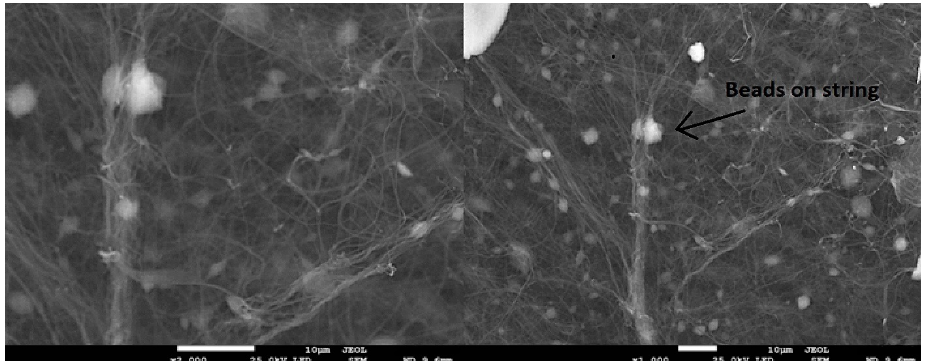
Figure 5. An example of beads on strings of textile resulting from polymerized electro-spun V 2 O 5 with PVP + Graphene Oxide diluted in water. Reprinted from ref. [17].